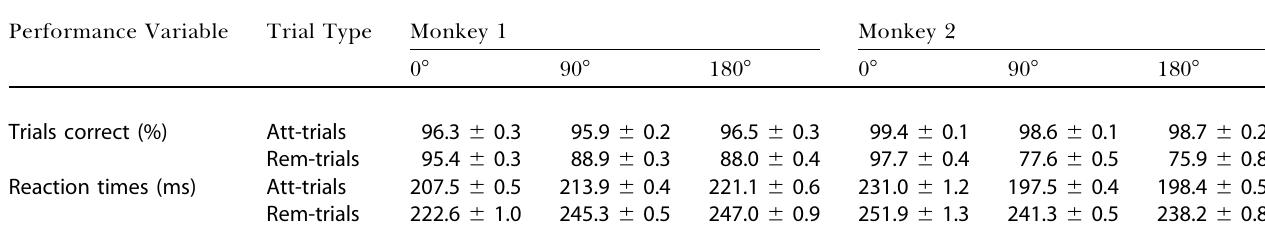
Table 1. Task Performance and Reaction Times for Each